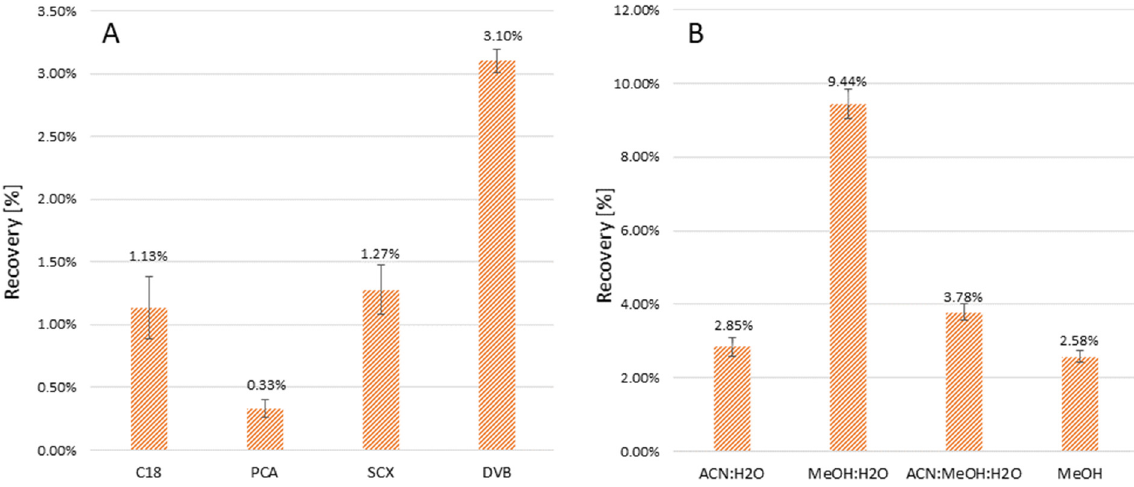
Figure 2. Optimization of imipenem recovery [%] for different adsorbents ( A ) and desorption solvents ( B ).